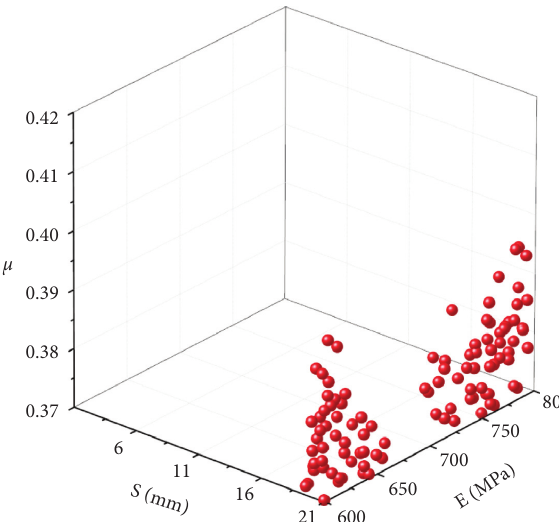
Figure 12: Distribution of parameter optimization results.